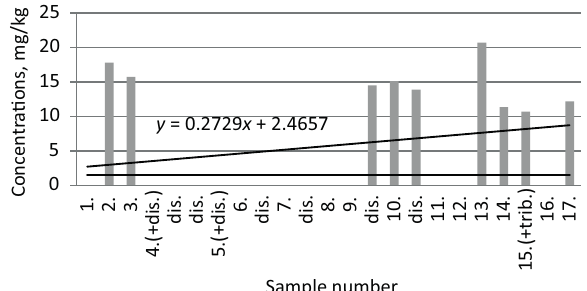
Fig 11. Cd concentrations on the right bank, downstream trend ( y ), the concentration of the I sludge category (bold line)